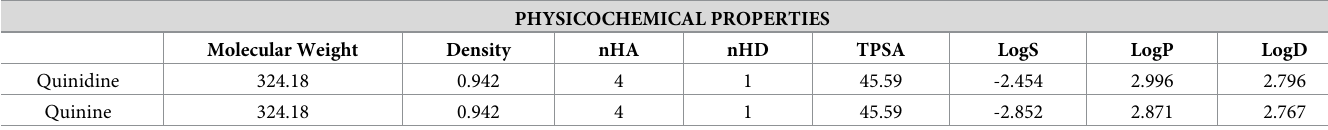
Table 4. Physicochemical properties of quinolone